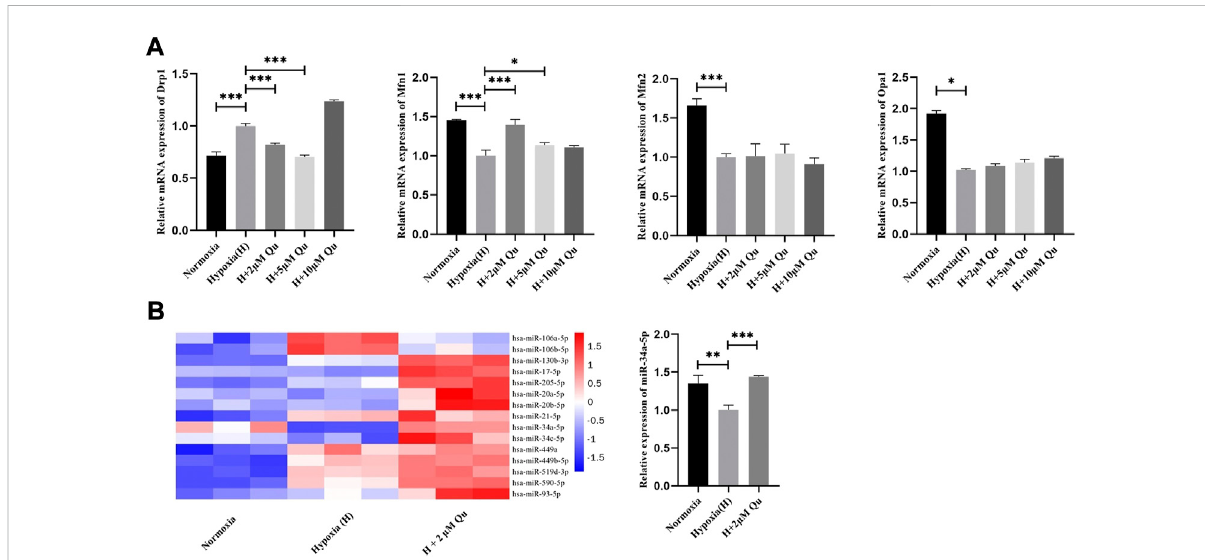
FIGURE 7 Regulation of quercetin on mitochondrial dynamics and key miRNAs in trophoblasts under hypoxia condition . (A) Expression of Drp1, Mfn1, Mfn2andOpa1inHTR-8/SvneocellsbyqRT-PCRanalysis. (B) ExpressionofkeymiRNAsinHTR-8/SVneocellsbyqRT-PCRanalysis. n =3,* p < 0.05,